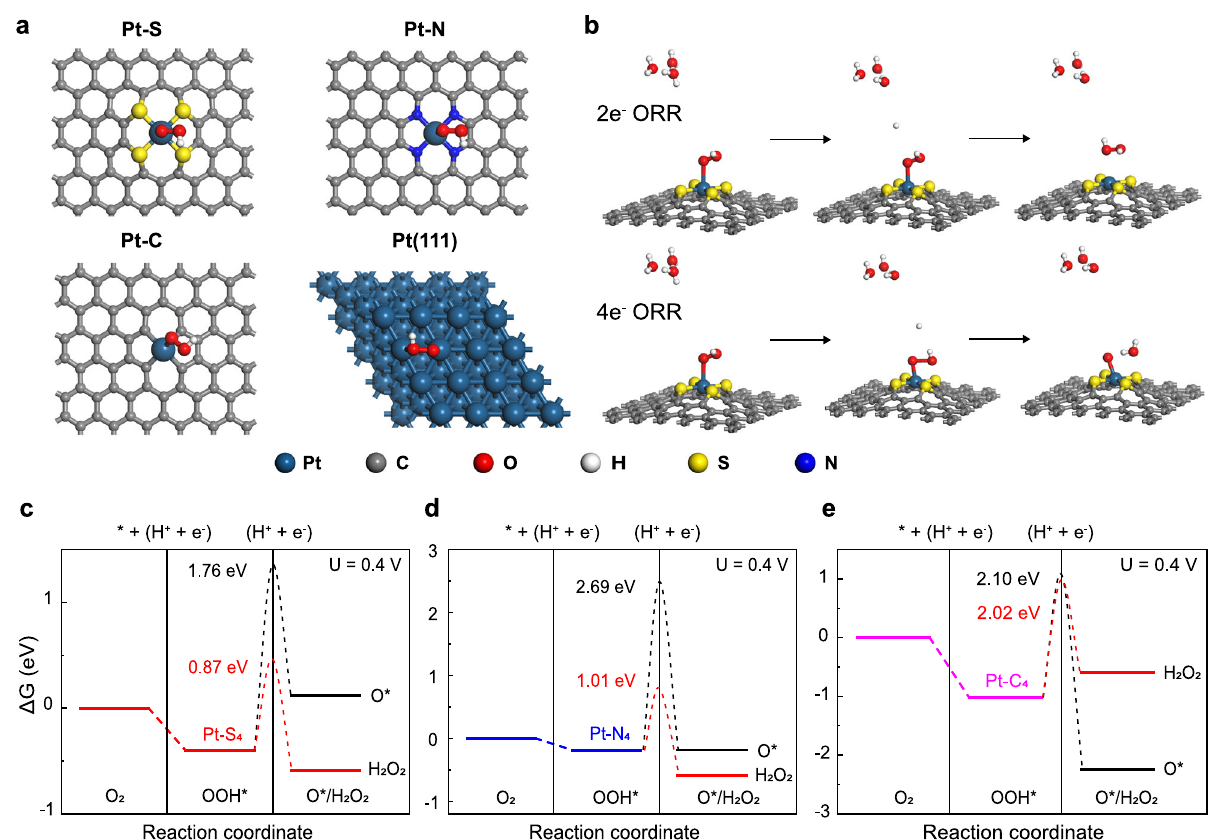
Fig. 3 DFT calculations of the ORR selectivity on different Pt-X-C moieties. a Examined con fi gurations for Pt single atom coordinated in two-dimensional carbon matrix with different metalloid doping, *OOH adsorption is preferable on central Pt sites over neighboring S/N/C atoms. b Illustration of oxygenated intermediates adsorption taking Pt-S 4 as an example, and relevant free energy diagrams for 2e – (red) or 4e – (black) ORR pathway on c Pt-S 4 , d Pt-N 4 and e Pt-C 4 motif. Insert numbers represent the kinetic barriers for *OOH to H 2 O 2 or *O, as computed by the Climbing Image Nudged Elastic Band (CI-NEB)